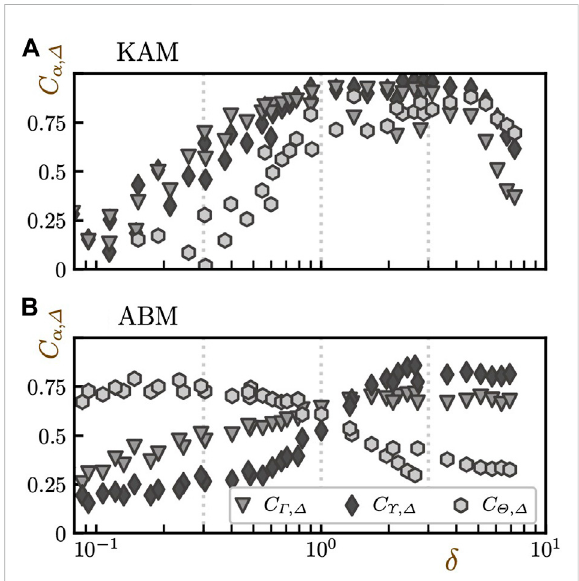
FIGURE 7 The evolution of the correlation between structural indicators (Grad-CAM score Γ , Voronoi volume ϒ , and TT-OP Θ ) and dynamic propensity Δ (or 1 − Δ depending on the target indicator and system) as a function of the mean intensity of the cage-relative displacement δ . Results for (A) KAM and (B) ABM. The meaning of the abscissa is the same as the one in Figure 5. Different markers distinguish different indicators, as shown in the legend. Data for all temperatures are plotted without distinction. The vertical dotted lines indicate the delta values visualized in Figures 1, 2.